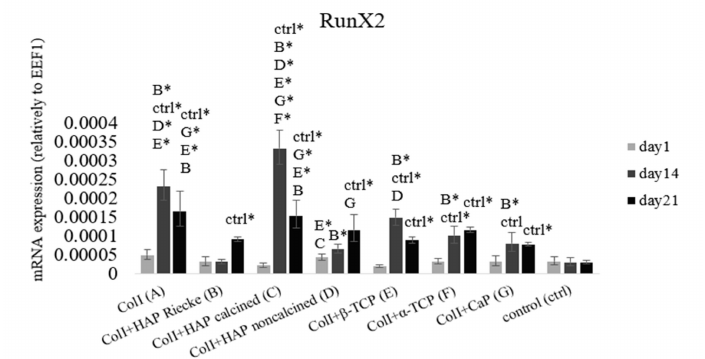
Figure 4. Early osteogenic marker RunX2 mRNA expression relative to EEF1D. Cells seeded on: Coll ( A ), ColI+HAP Reicke ( B ), ColI+HAP calcined ( C ), ColI+HAP noncalcined ( D ), ColI+ β -TCP ( E ), ColI+ α -TCP ( F ) and ColI+CapolyP ( G ). Negative control group—MSCs on tissue culture plastics. Statistical significance marked with the name of group and asterisk sign for p < 0.01.